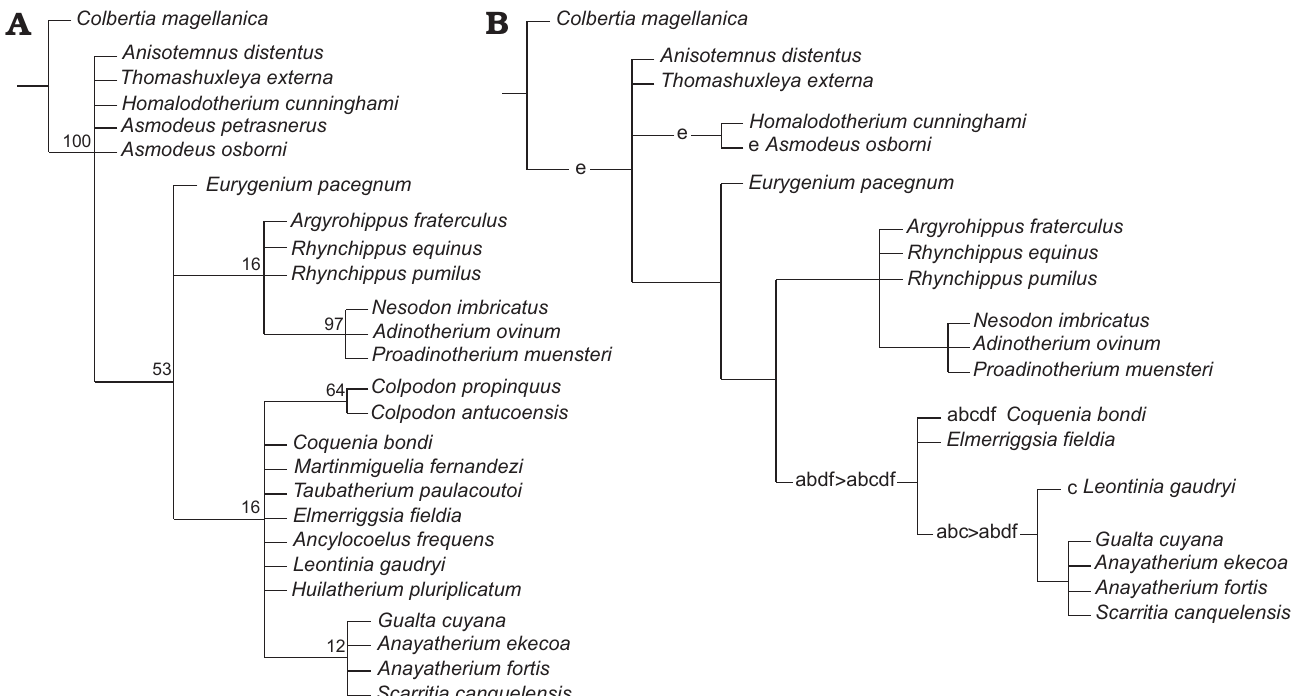
Fig. 8. Consensus trees from phylogenetic analyses under equal weights. A . Strict consensus tree. B . Reduced consensus tree. a, Martinmiguelia fernandezi ; b, Taubatherium paulacoutoi ; c, Ancylocoelus frequens ; d, Huilatherium pluriplicatum ; e, Asmodeus petrasnerus ; f, Colpodon antucoensis + C. propinquus